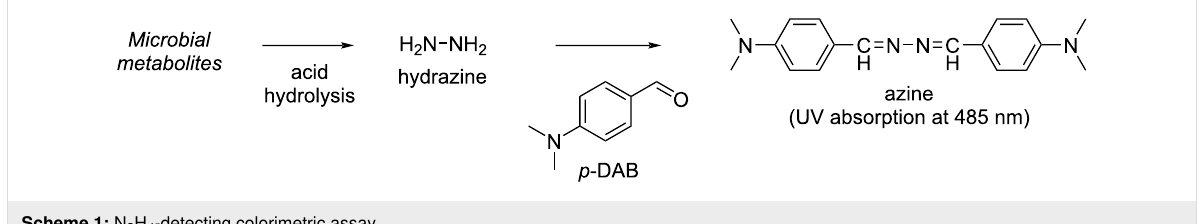
Scheme 1: N 2 H 4 -detecting colorimetric